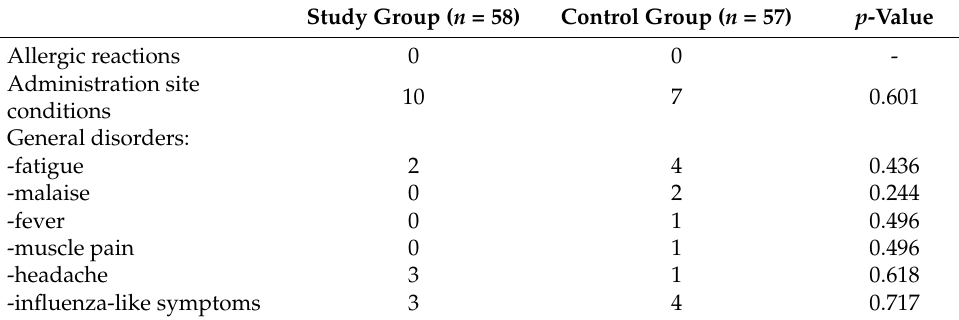
Table 3. The number of patients among the study and control groups reporting adverse reactions after